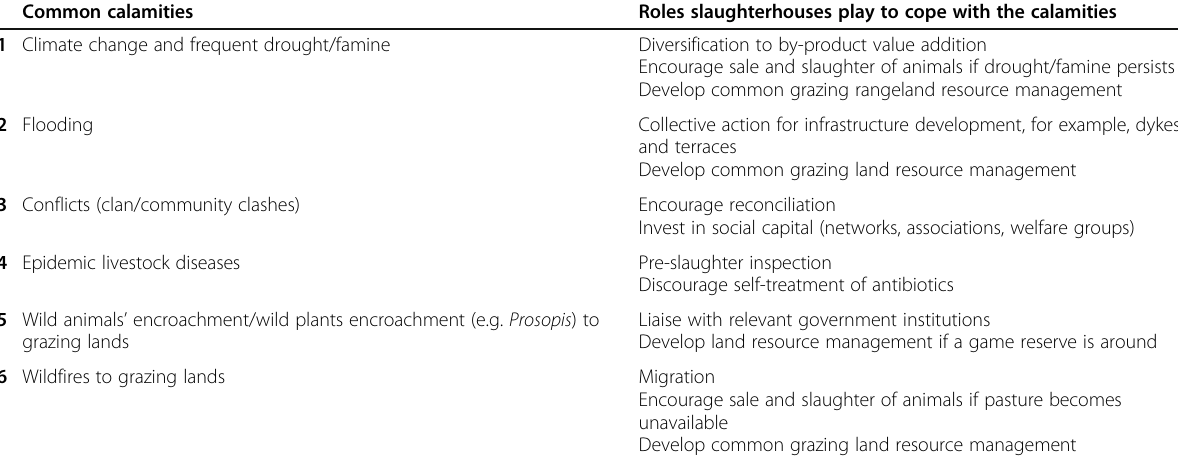
Table 1 Strategies slaughterhouses use to cope with calamities in the pastoral areas Common calamities Roles slaughterhouses play to cope with the